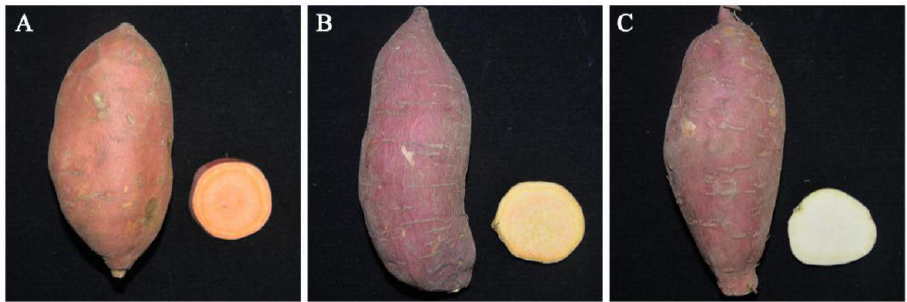
Figure 1. Phenotypic characteristics of 3 sweetpotato cultivars that represent the storage roots and the storage root cross-sections of ( A ) Y25, ( B ) Z13, and ( C ) X27,